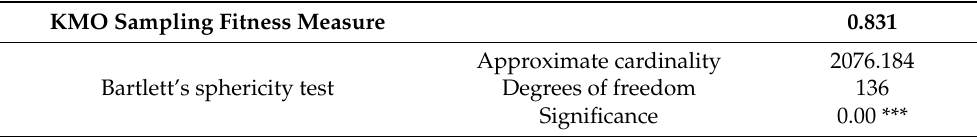
Table 8. Results of KMO measure and Bartlett’s sphericity test.